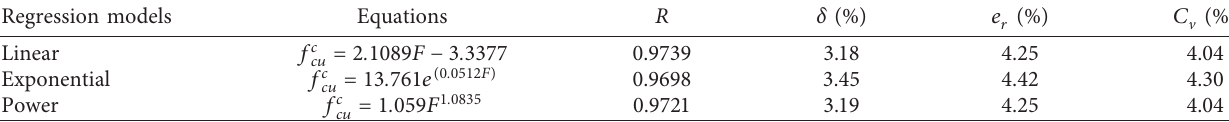
Table 11: Various regression models used to estimate the compressive strength of CFRC from postinstalled pull-out forces. Regression models